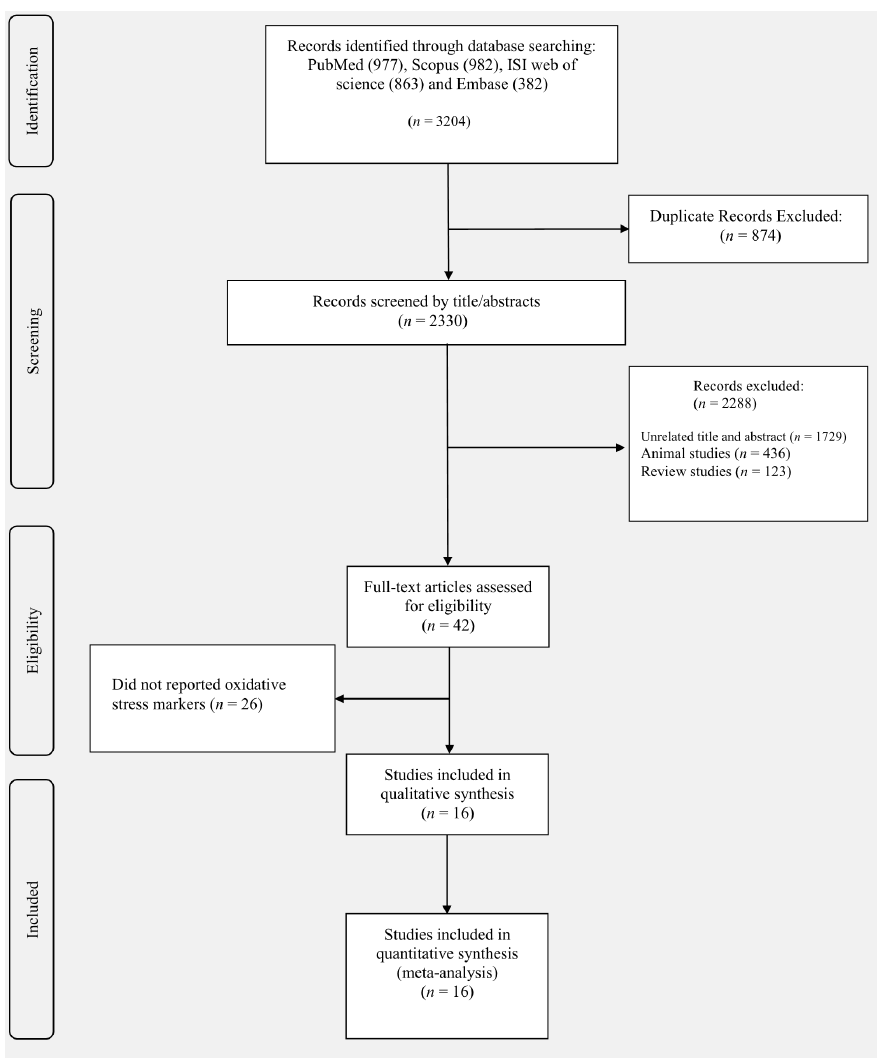
Figure 1. The flow chart of the literature search .